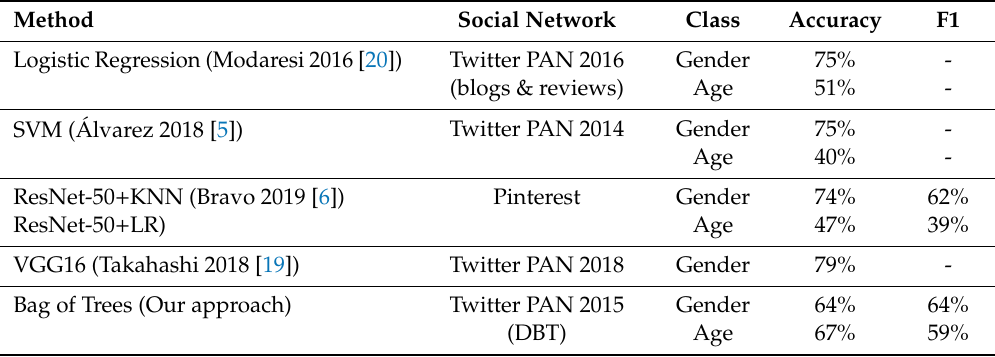
Table 6. Age and Gender prediction comparison with related approaches analyzing text from social network users.